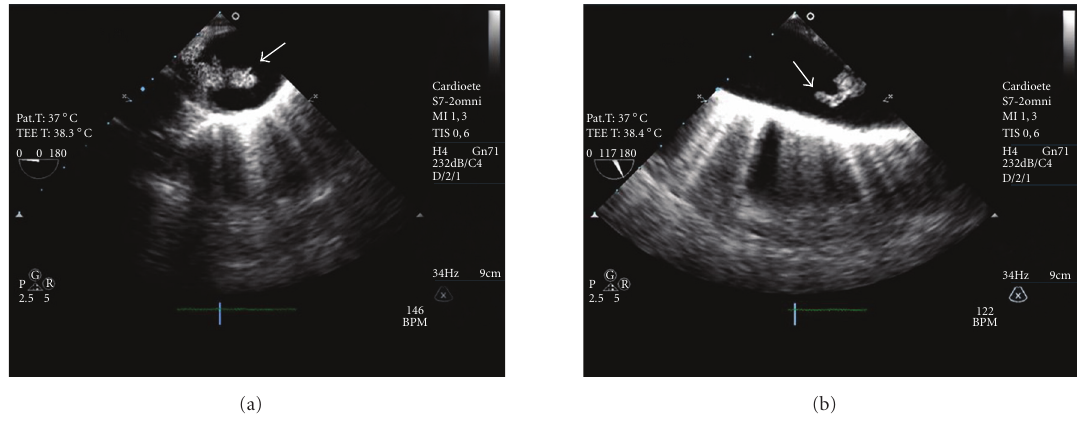
Figure 2: (a) Transesophageal echocardiogram (TEE) image of the proximal descending aorta (PDA) with sectioning plane at 0 ◦ . A large polypoid sessile vegetation (2.1 × 0.9 cm) attached to the intima can be seen at the beginning of descending thoracic aorta ( arrow ); (b) TEE image of the PDA with sectioning plane at 117 ◦ , showing the same vegetation ( arrow ).